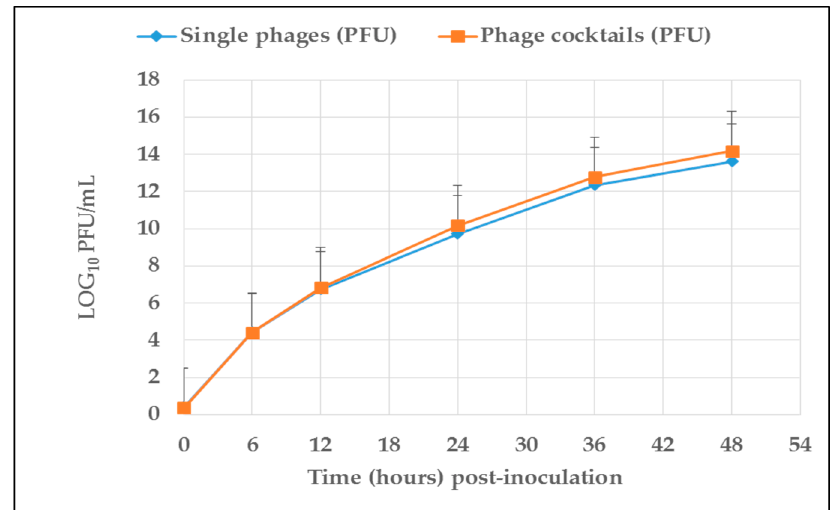
Figure 1. Average concentration of single phages and phage cocktails (PFU/mL) recovered from rumen contents at different incubation times. Standard deviation is represented by the error bars. Table 1. Relationship between single phage titres ( y ) and in vitro ruminal incubation time ( x ). Single Phage